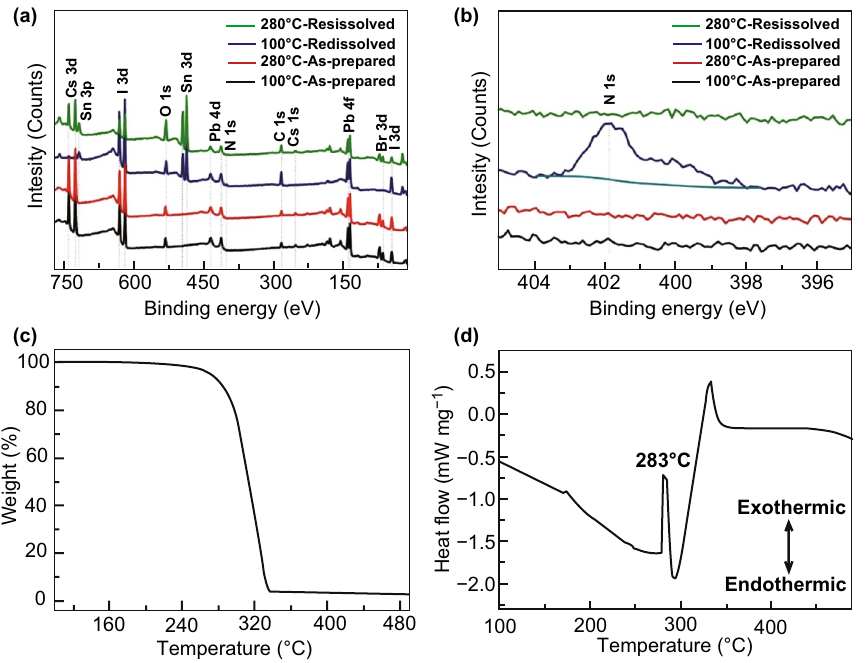
Fig. 1 a XPS survey spectra of as-prepared and in situ redissolved CsPbIBr 2 films annealed at 100 °C and 280 °C, b corresponding core-level N 1 s XPS spectra, c TGA heating curve of PEAI powder expressed as weight% as a function of applied temperature, d DSC curve of PEAI